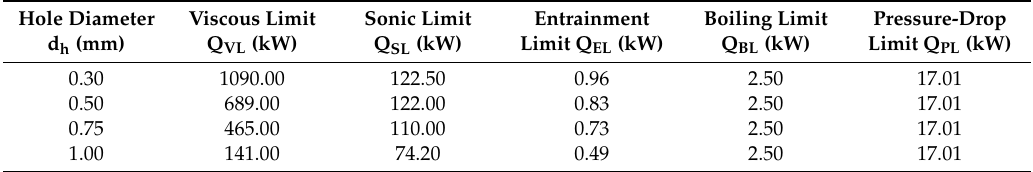
Table 5. Impact of the condenser-to-absorber height difference.